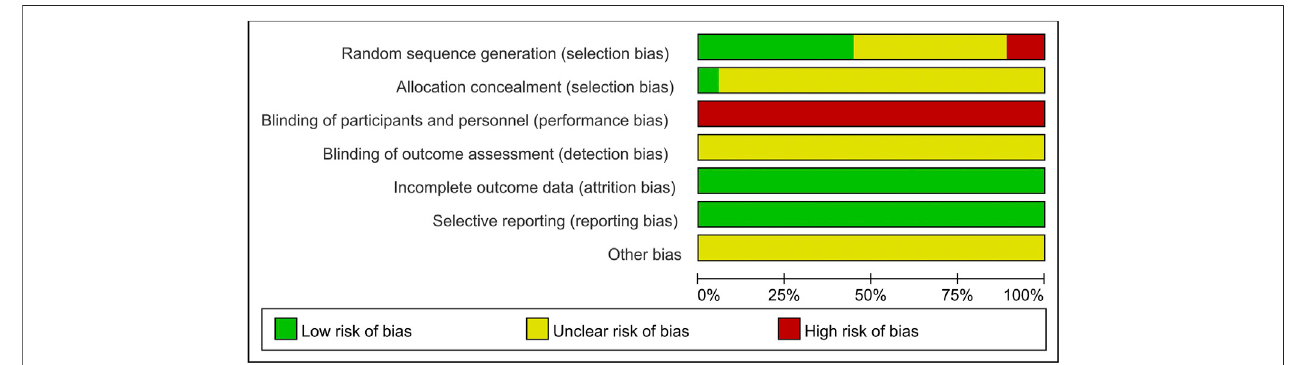
FIGURE 2 | Risk of bias